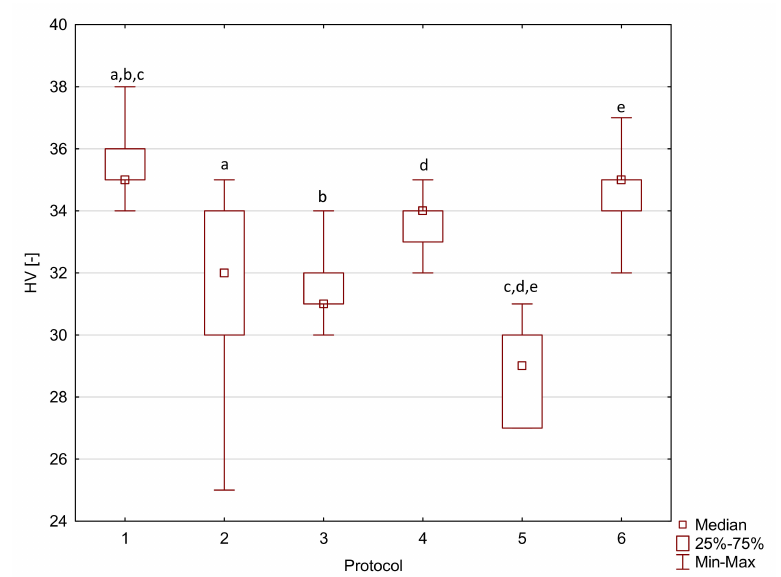
Figure A6. Box-and-whisker plot of Vickers hardness (HV) of Flow-Art material. Statistically- significant differences were detected between the following: (a,b,c) Protocol 1 (water, 24 h, 37 ◦ C) vs. (a) Protocol 2 (artificial saliva, 90 days, 37 ◦ C) ( p = 0.010352); (b) Protocol 3 (water, 500 thermocycles, 5/55 ◦ C) ( p = 0.004079); (c) Protocol 5 (0.1 M NaOH, 7 days, 60 ◦ C) ( p = 0.000003); (d,e) Protocol 5 (0.1 M NaOH, 7 days, 60 ◦ C) vs. (d) Protocol 4 (water, 7500 thermocycles, 5/55 ◦ C) ( p = 0.016355); (e) Protocol 6 (water, 5 days, 55 ◦ C) ( p = 0.000164).